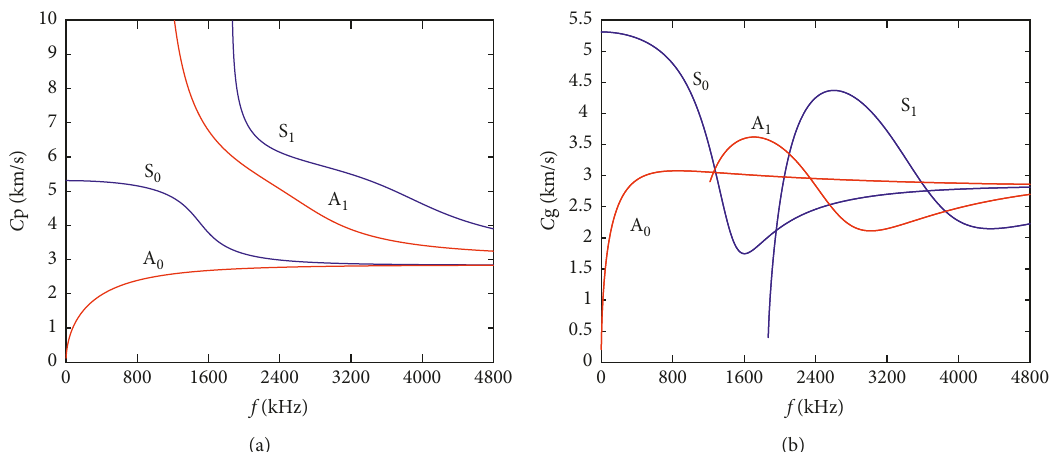
Figure 4: Disperse curve of (a) phase velocity and (b) group velocity.